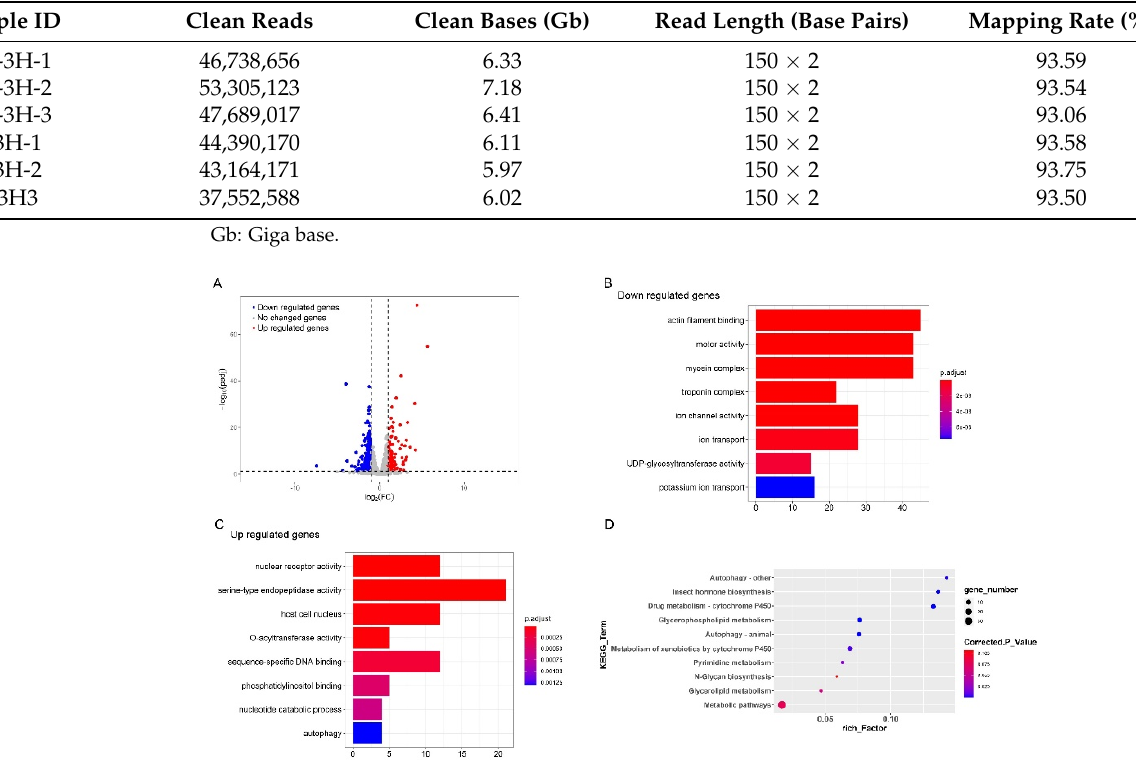
Table 1. Summary of the sequence assembly after Illumina sequencing.